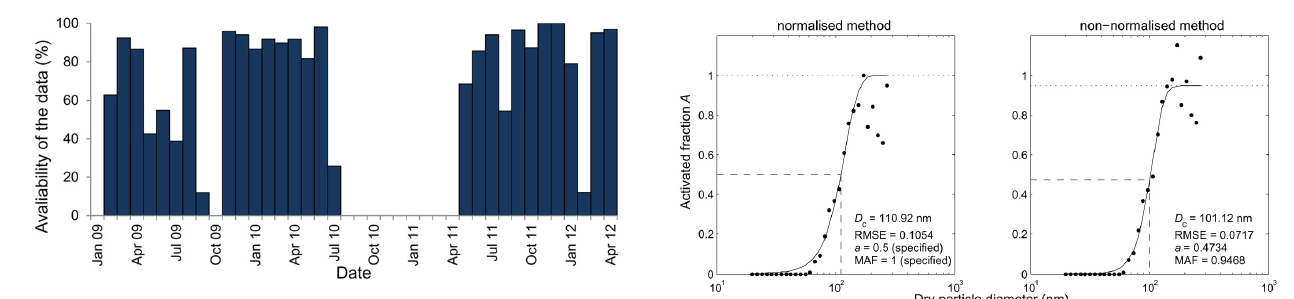
Fig. 1. Monthly availability of CCNC data.